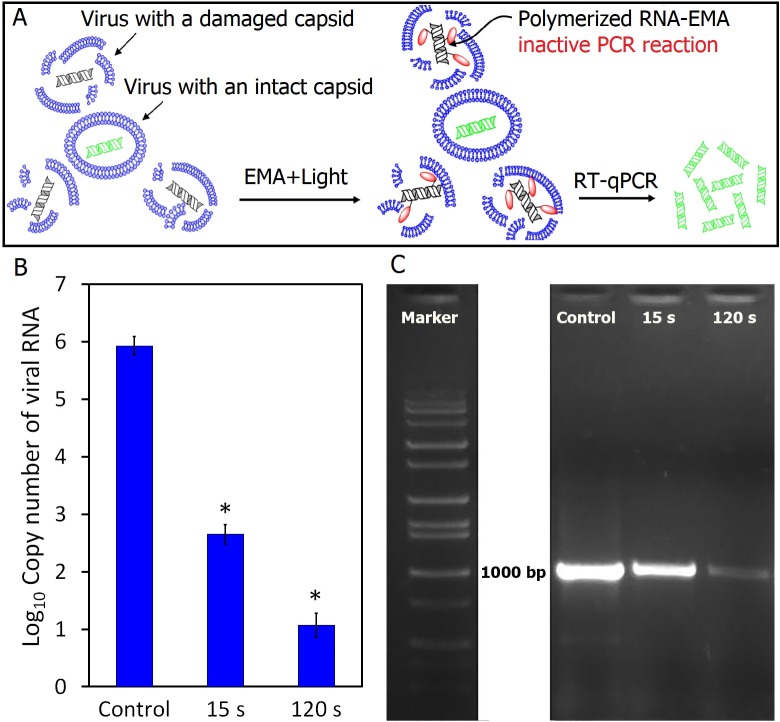
Quantification of capsid-destruction as a function of CAP-exposure time.A) Diagram explaining the principle of RT-qPCR coupled with ethidium monoazide (EMA-RT-qPCR). B) The titer of capsid-intact FCV after 15 and 120 s exposures to CAP as compared to control (CAP-unexposed). The data are average of triplicate measurements and error bars represent standard deviation. Labels on top of columns refer to the significance of RNA concentration as compared to control of each sample [*: Statistically significant (P≤0.05)]. C) The agarose gel patterns of EMA-coupled conventional RT-PCR products generated from viral RNA obtained from 15s and 120s CAP-exposed and unexposed FCV samples. Aliquots (100 μl) of 15s and 120s CAP-exposed FCV were mixed with 5μg EMA/100 μl followed by incubation at 4°C for 30 min in dark. Samples were then exposed to light (using a 650W halogen bulb) for 5 min in ice bath followed by viral RNA extraction. Quantification of PCR-reactive and PCR-nonreactive RNAs in control and CAP-exposed samples was carried out by RT-qPCR. Conventional RT-PCR reactions were carried out using RNA extracted from control and CAP-exposed samples to compare them qualitatively based on agarose gel patterns of a region of viral RNA nucleotide.